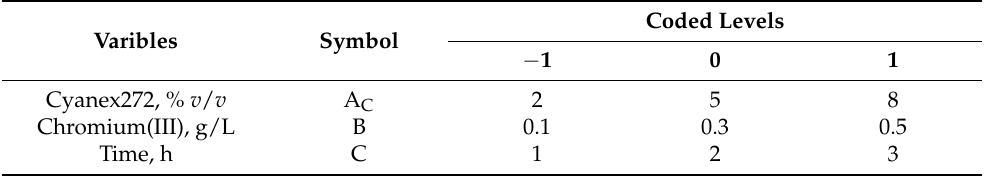
Coded Levels − 1 0